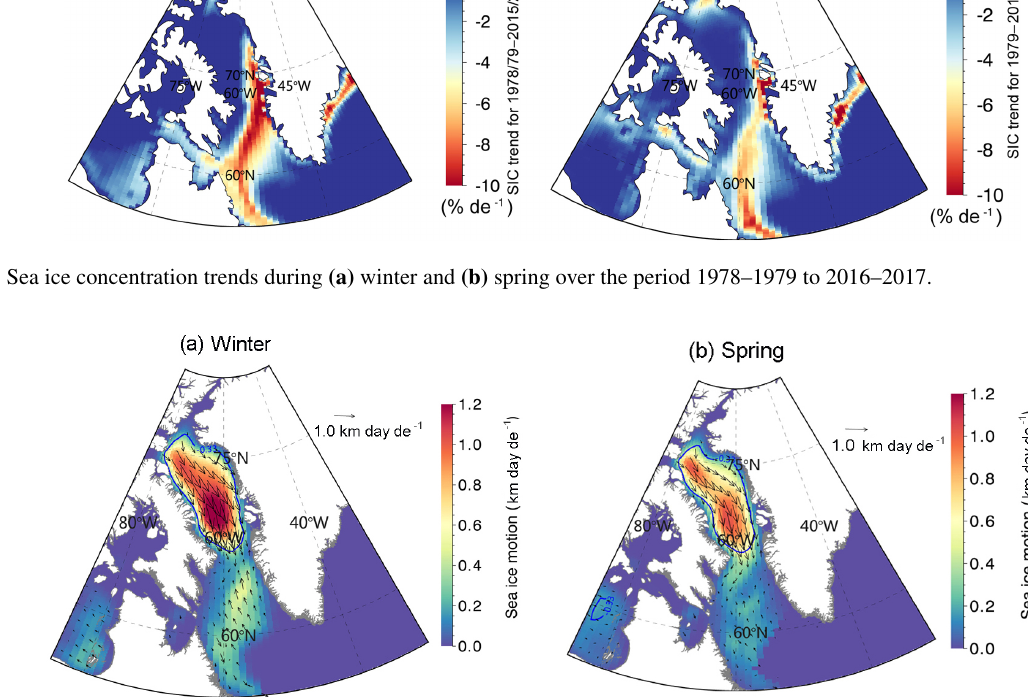
Figure 10. As Fig. 8 but for sea ice motion